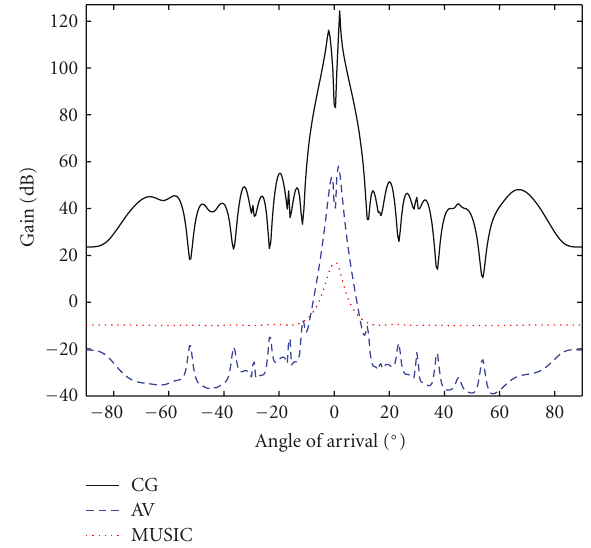
Figure 1: CG, AV, and MUSIC spectra ( θ 1 = − 1 ◦ , θ 2 = 1 ◦ , SNR1 = SNR2 = 10dB, K = 50).